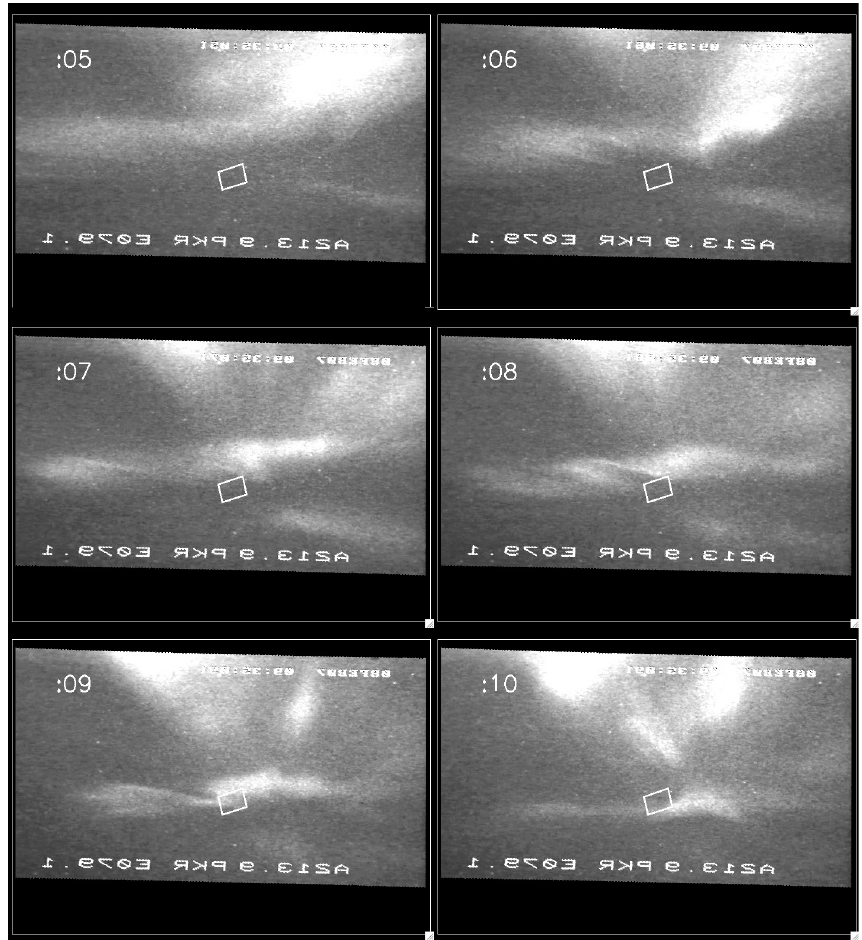
Fig. 4. Series of mapped camera images taken on every second corresponding to the times in Fig. 3. This shows the active dynamic auroral arc passing through the radar beam, denoted by the white box. An altitude of 100km is assumed for the location of the aurora and the radar beam location. The time in seconds from 09:35UT is shown in the upper left corner of each image. (In magnetic coordinates, north is up and east is to the